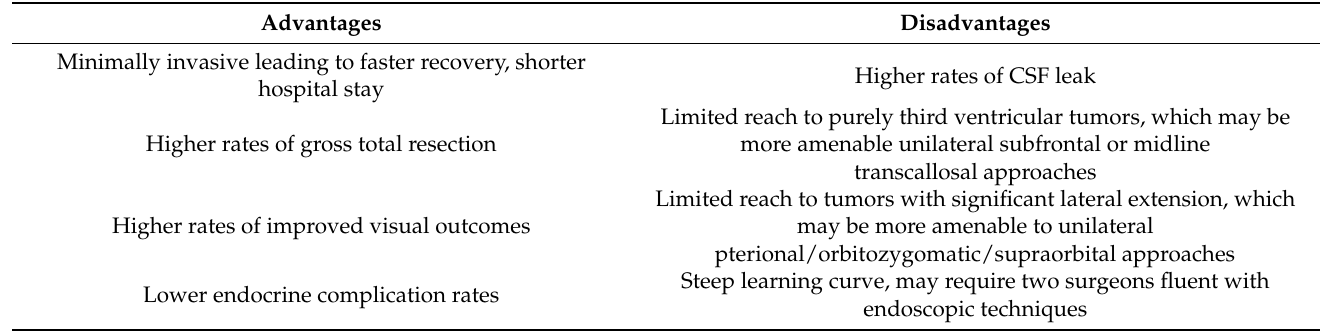
Table 1. Key advantages and disadvantages of the endoscopic endonasal approach for craniopharyngiomas. Advantages